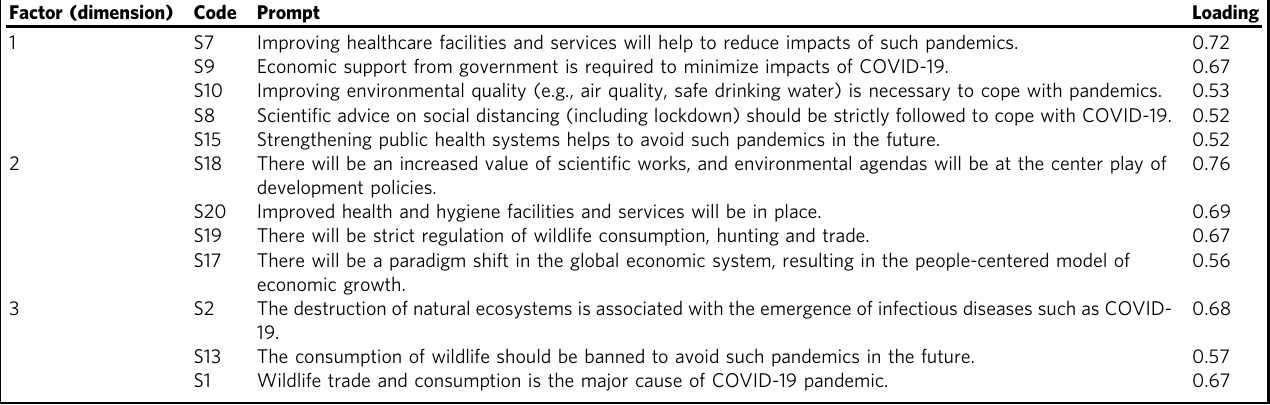
Table 1 A factor loading of COVID-19 prompts (prompts 14 – 33 with loading greater than 0.500) about “ causes and spread of the COVID-19 ” , “ coping with the COVID-19 pandemic ” , “ avoiding future pandemics ” and “ expectations after COVID-19 based on exploratory factor